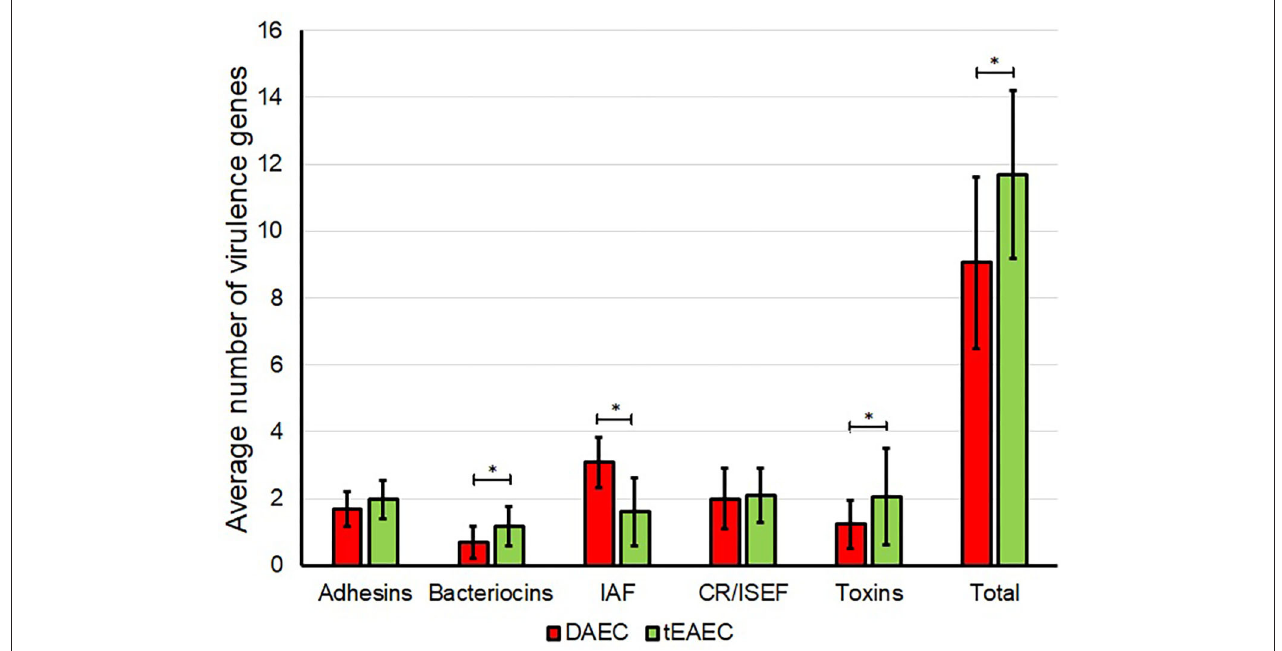
FIGURE 3 | Distribution of virulence genes in DAEC and tEAEC strains. The average number of different groups of virulence genes detected by PCR in DAEC (red) and tEAEC (green) strains are shown. Asterisks indicate a significant difference in the number of virulence genes between both pathotypes ( P < 0.05, MWUT). CR/ISEF, Complement resistance/Immune system evasion factors; IAF, Iron acquisition